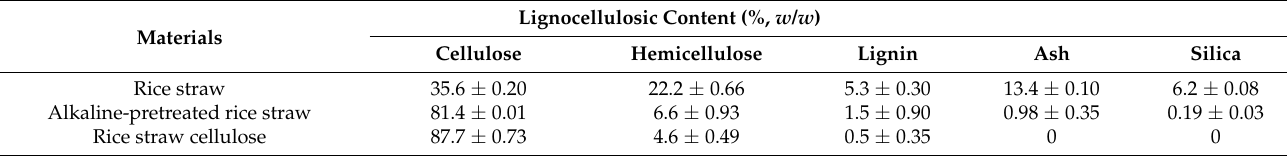
Table 2. Lignocellulosic composition of raw material and treated rice straw.